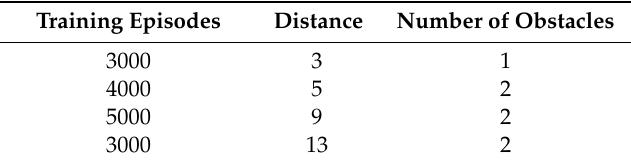
Table 1. The first part of learning task based on transfer